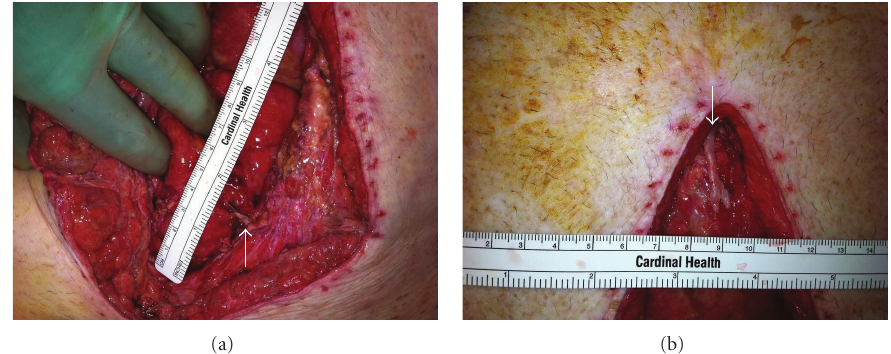
Figure 1: Intraoperative photographs demonstrating the (a) location of 3 mm × 1cm heterotopic ossification within inferior midline wound and repaired small bowel perforation. Arrow denotes heterotopic ossification emanating from the wound. (b) Additional area of heterotopic ossification, 7mm × 2.3cm, in superior aspect of the wound. Arrow denotes heterotopic ossification emanating from the wound.